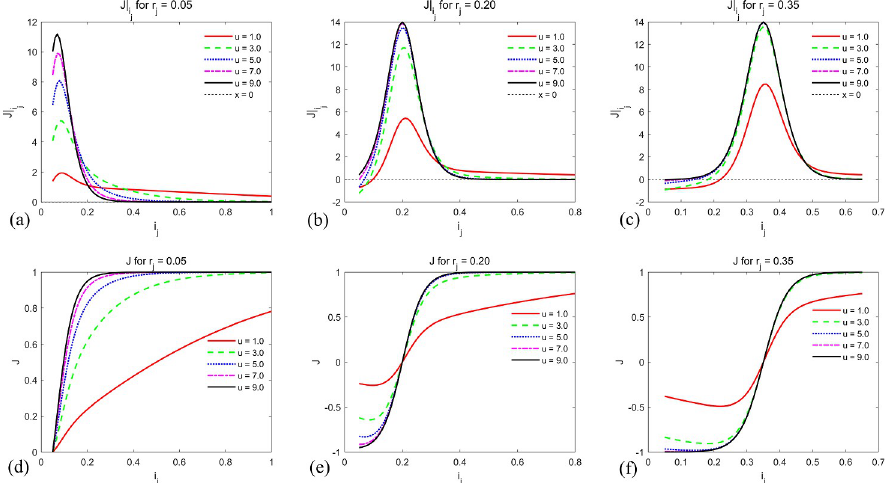
Fig 5. The change tendency of J and J j and u with r = 0.05, 0.20, 0.35, respectively. While (d)–(f) shows the change of J by different i j 0.20, 0.35, respectively.